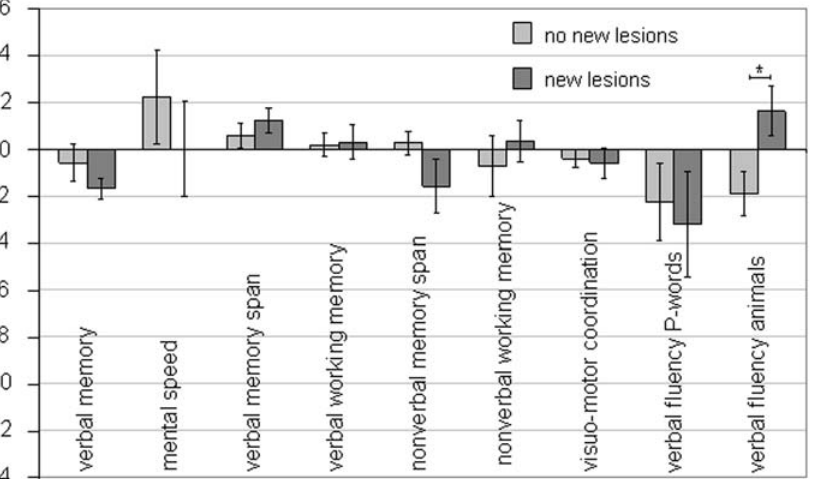
Figure 3. Comparison of the two groups with (dark grey) and without (light grey) new lesions in DWI in terms of the extent of pre-to postinterventional cognitive change. Statistical significances are indicated. * p , 0.05.